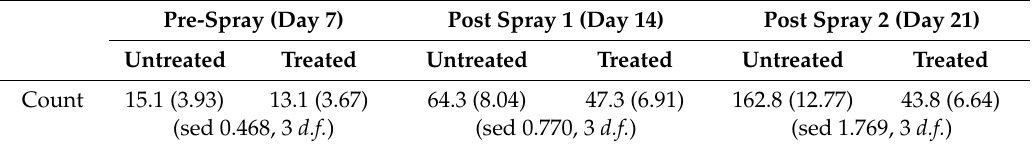
Table 7. Mean total number of B. brassicae recorded per cabbage plant after two treatments with Botanigard ES ( B. bassiana ) in field experiment 1 (square root-transformed data are given in parentheses). Applications of Botanigard ES were done on days 7 and 14 after inoculation of plants with aphids. Counts of aphid numbers were done immediately prior to spraying on day 7 and day 14, and 7 days after the second spray ( = day 21).